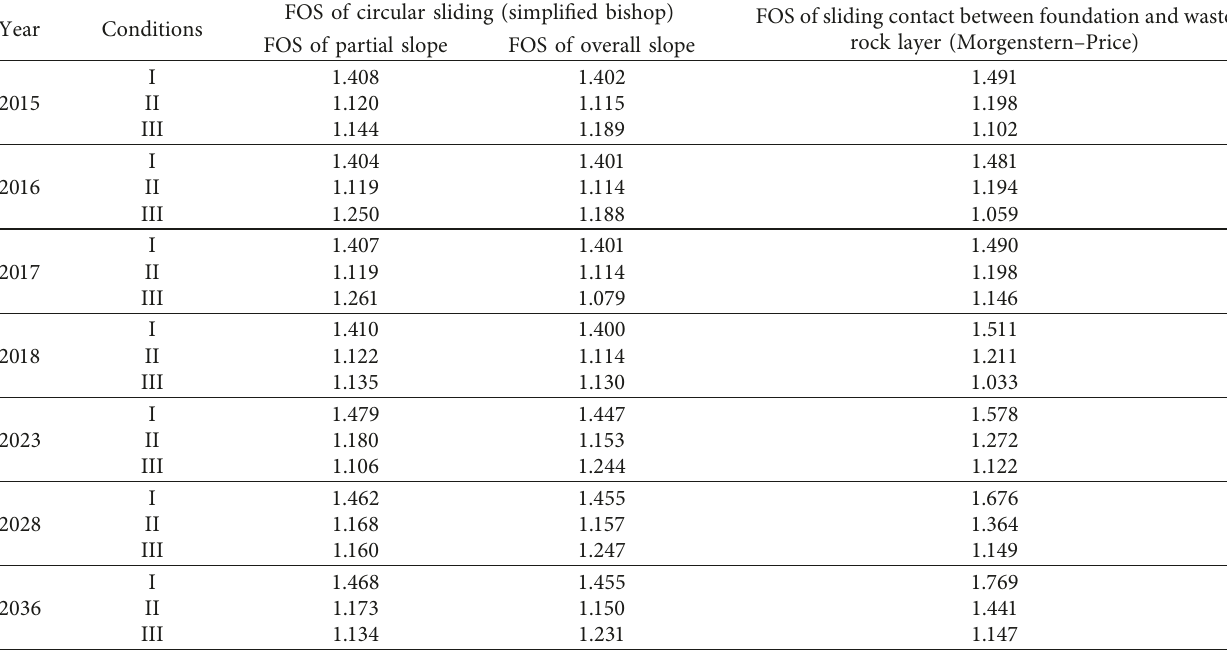
Table 12: Calculation results using limit equilibrium